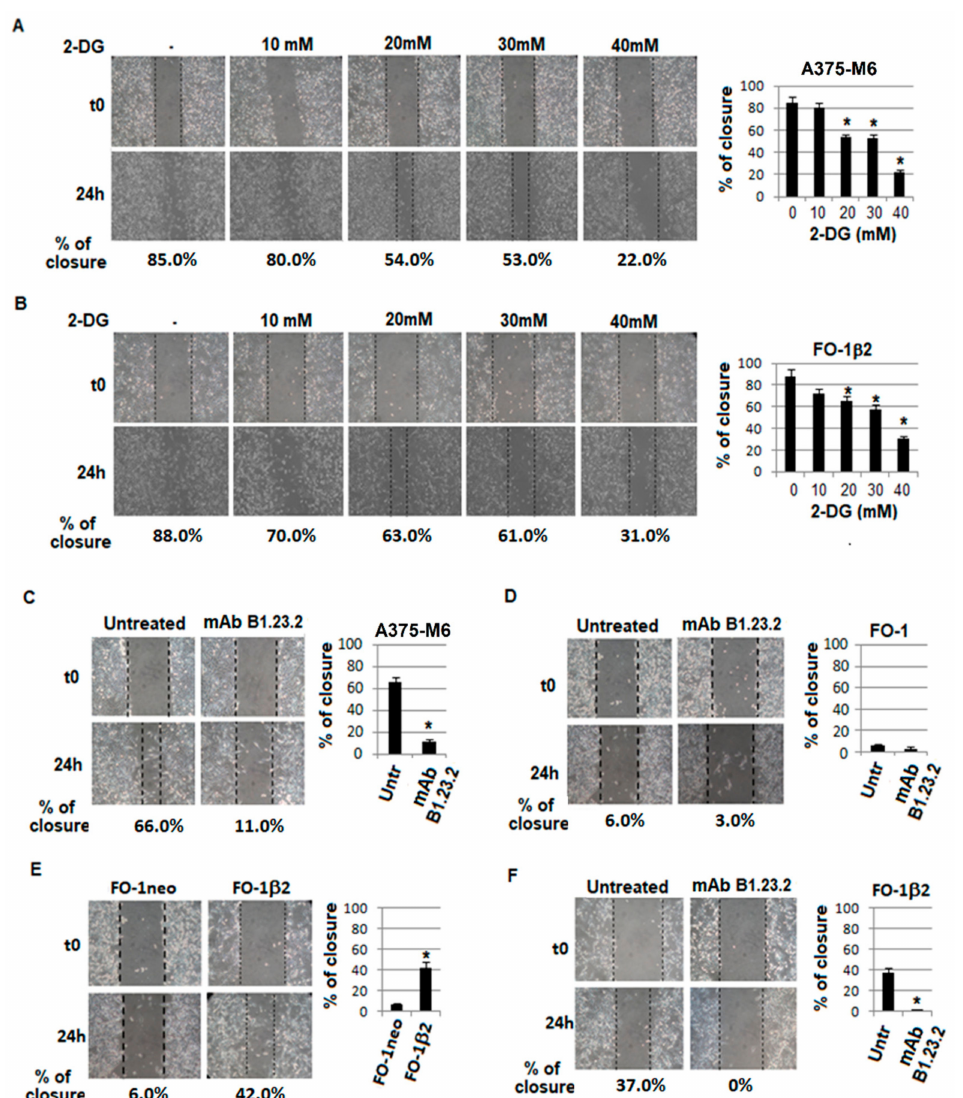
Figure 4. E ff ect of 2DG and HLA-B,C-specific mAb B1.23.2 on cell motility. E ff ect of 2-DG on: motility of A375-M6 cells ( A ) and FO-1 β 2 cells ( B ), evaluated by scratch wound healing assay. A wound healing assay was used also to evaluate the migration of A375-M6 ( C ) and FO-1 ( D ) cells treated with the HLA-B,C-specific mAb B1.23.2 (10 µ g / mL) for 24 h at 37 ◦ C; di ff erential migration of FO-1neo and FO-1 β 2 cells ( E ) and migration of FO-1 β 2 cells after treatment with the HLA-B,C-specific mAb B1.23.2 (10 µ g / mL) for 24 h at 37 ◦ C ( F ). Values presented are the mean ± SEM of the results obtained in three independent experiments. * p <